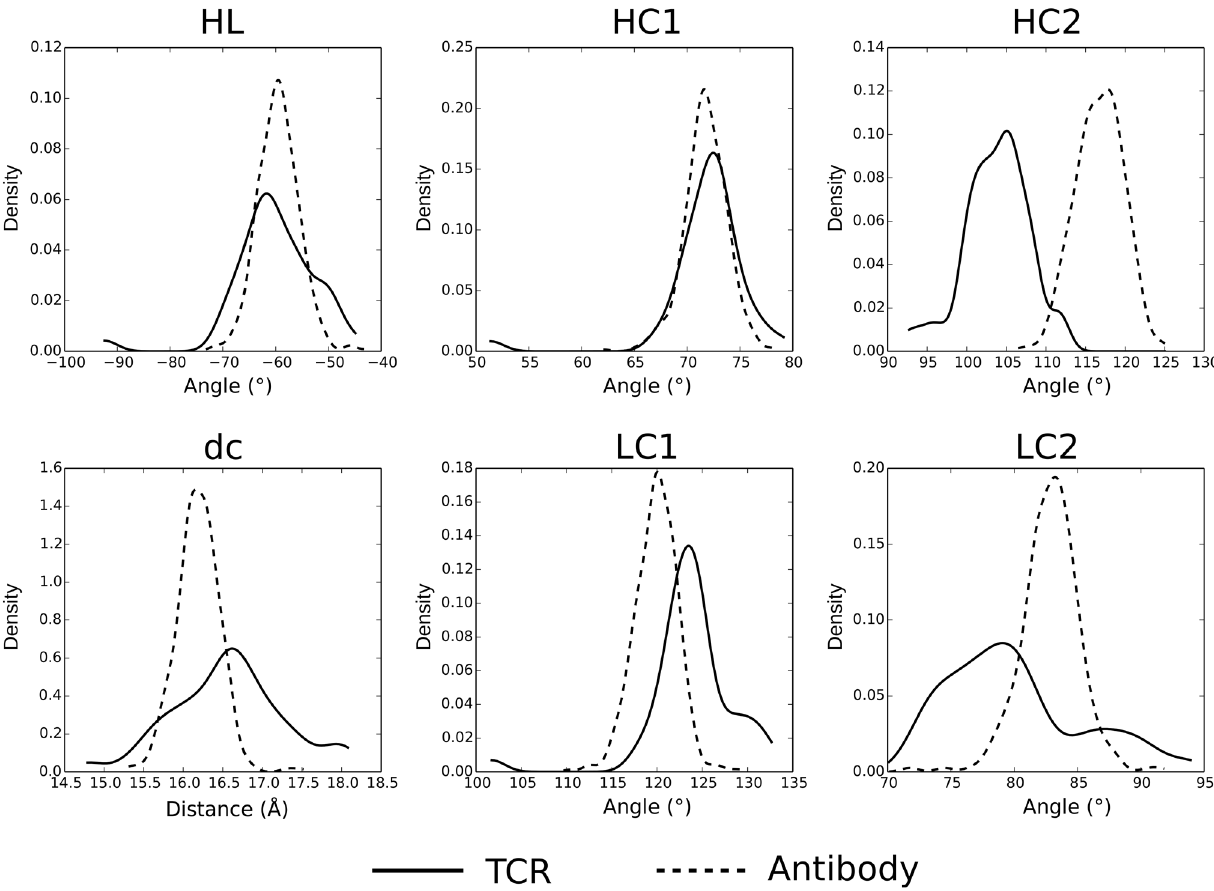
Figure 3. The ABangle orientation measures for antibodies and TCRs. The receptor types are found to have different orientations. The difference is best characterised by the HC2 angle. This corresponds to a twist of the VH or V b domain with respect to the VL or V a domain respectively.